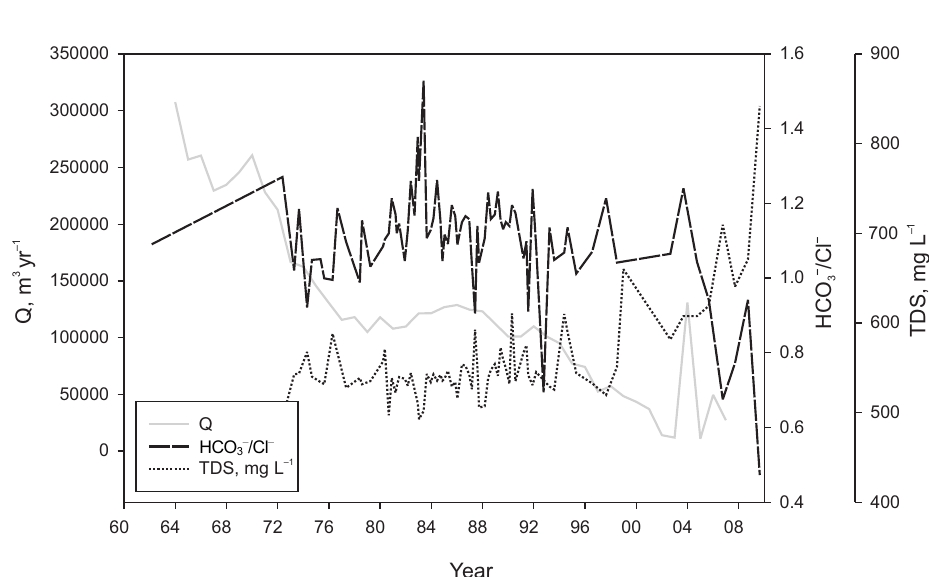
Fig. 9. Changes in groundwater abstraction from well 2198 and those in TDS and HCO 3 (cid:150) /Cl (cid:150) ratios in the abstracted water. Missing chemistry data from years 1998 to 2002 are interpolated.